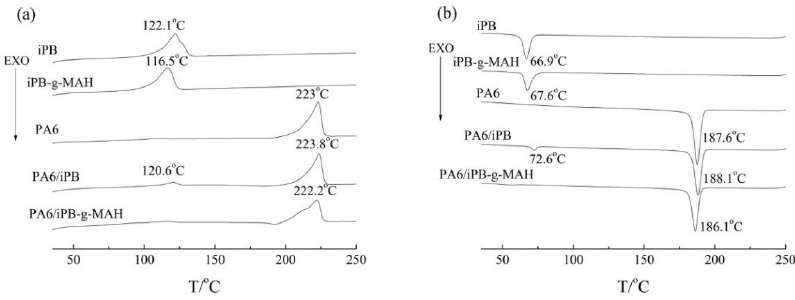
Figure 15. DSC melting curves ( a ) and crystallization curves ( b ) of different samples. Table 3. DSC data of PA6.